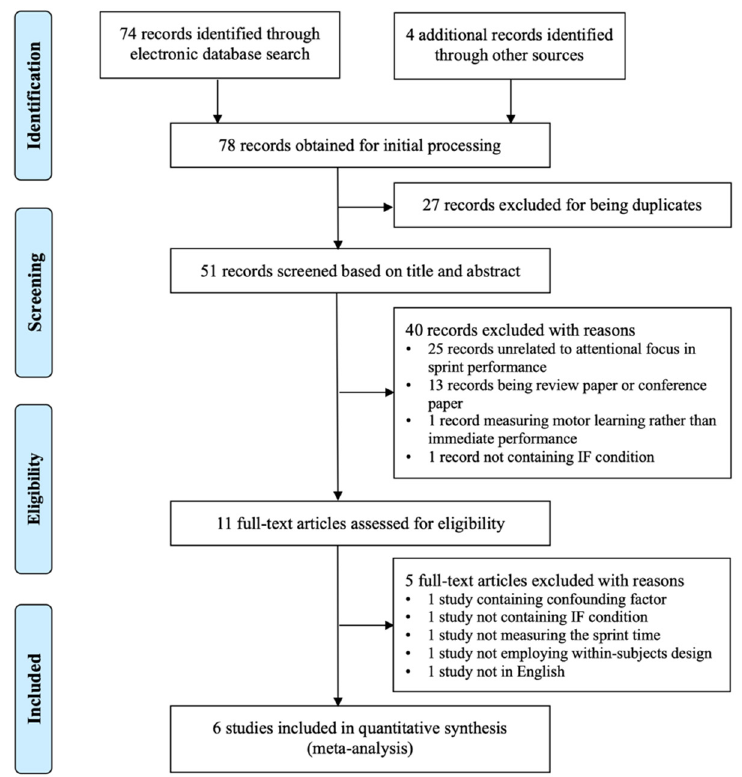
Figure 1. Flow diagram of literature selection process.